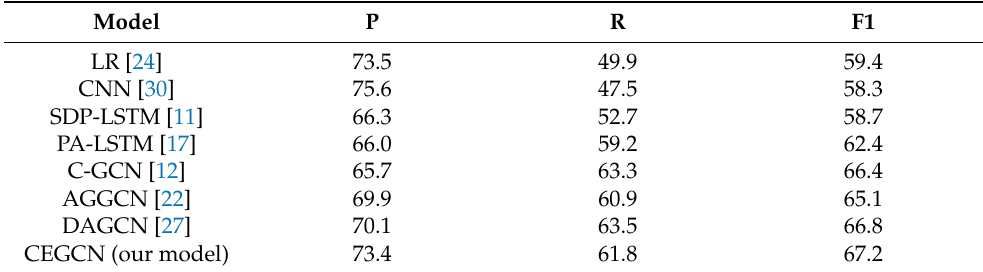
Table 2. Results on the TACRED dataset.